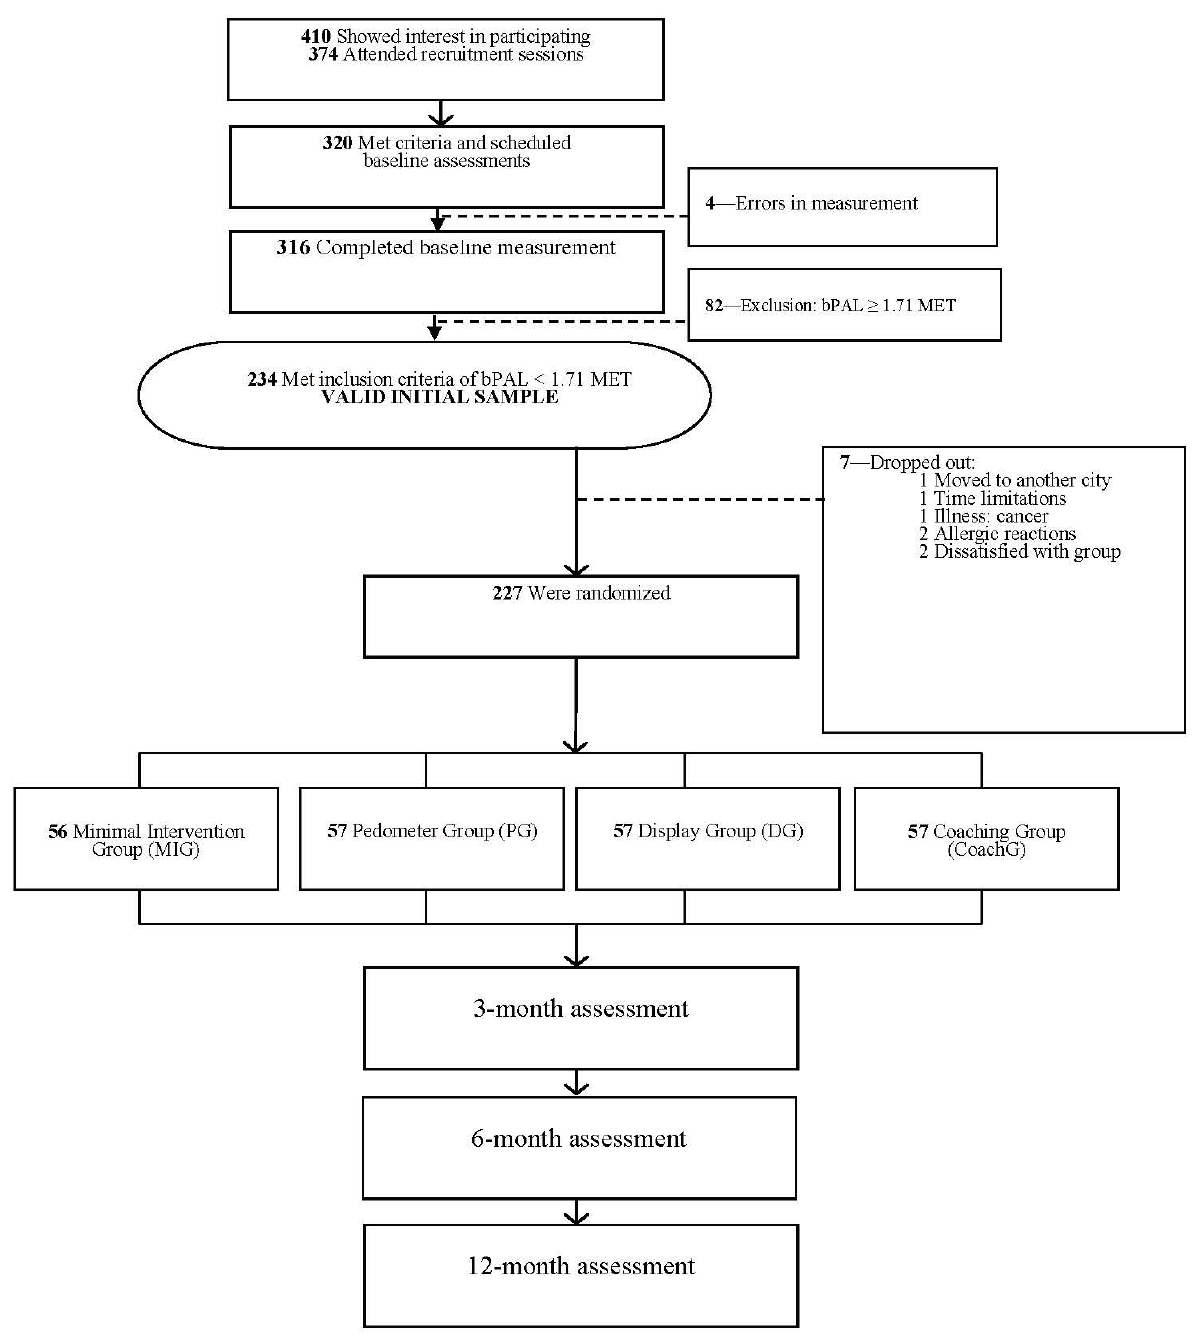
Figure 1. Participants flow from screening to randomization. Abbreviations: bPAL, Physical Activity Level at baseline; MET, Metabolic